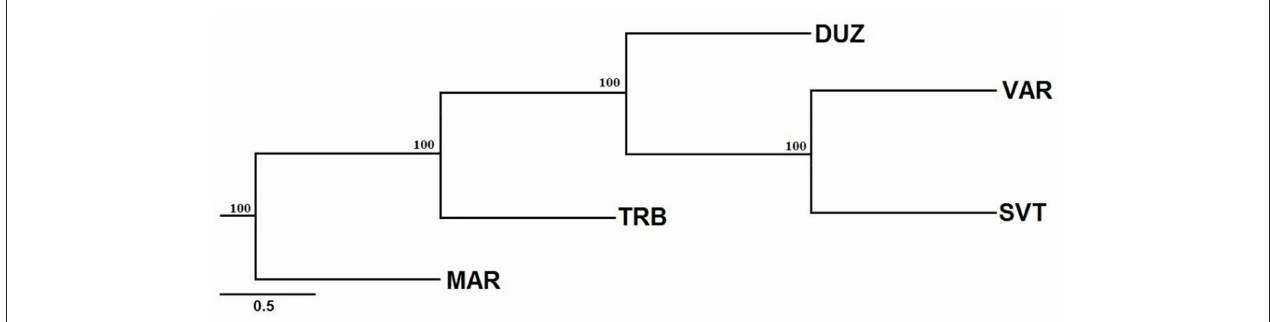
FIGURE 4 | Neighbor-joining tree based on microsatellite variation. Bootstrap values of 1,000 replications are given on nodes in percentages. The abreviations of the samples were given in Figure 1 .